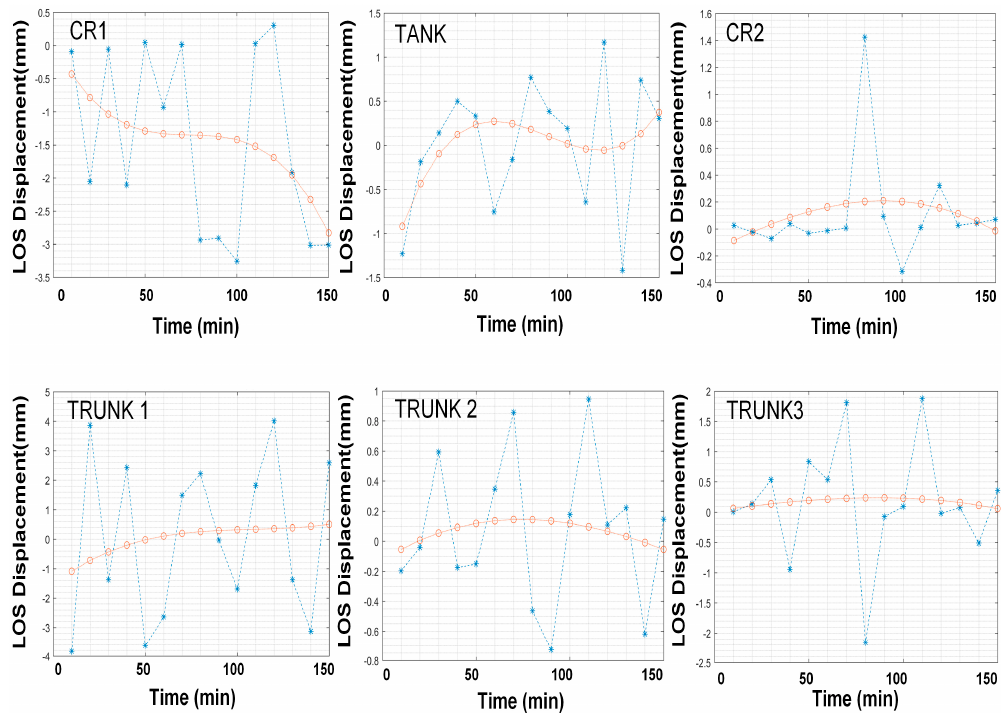
Figure 17. Displacements comparison of selected points in time series, T1, T2, and T3 in Figure 16 correspond to TRUNK1, TRUNK2, and TRUNK3 respectively.